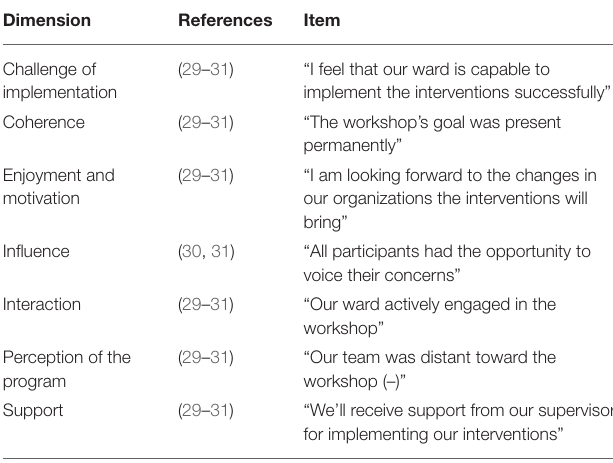
TABLE 3 | Functional aspects of developing and implementing